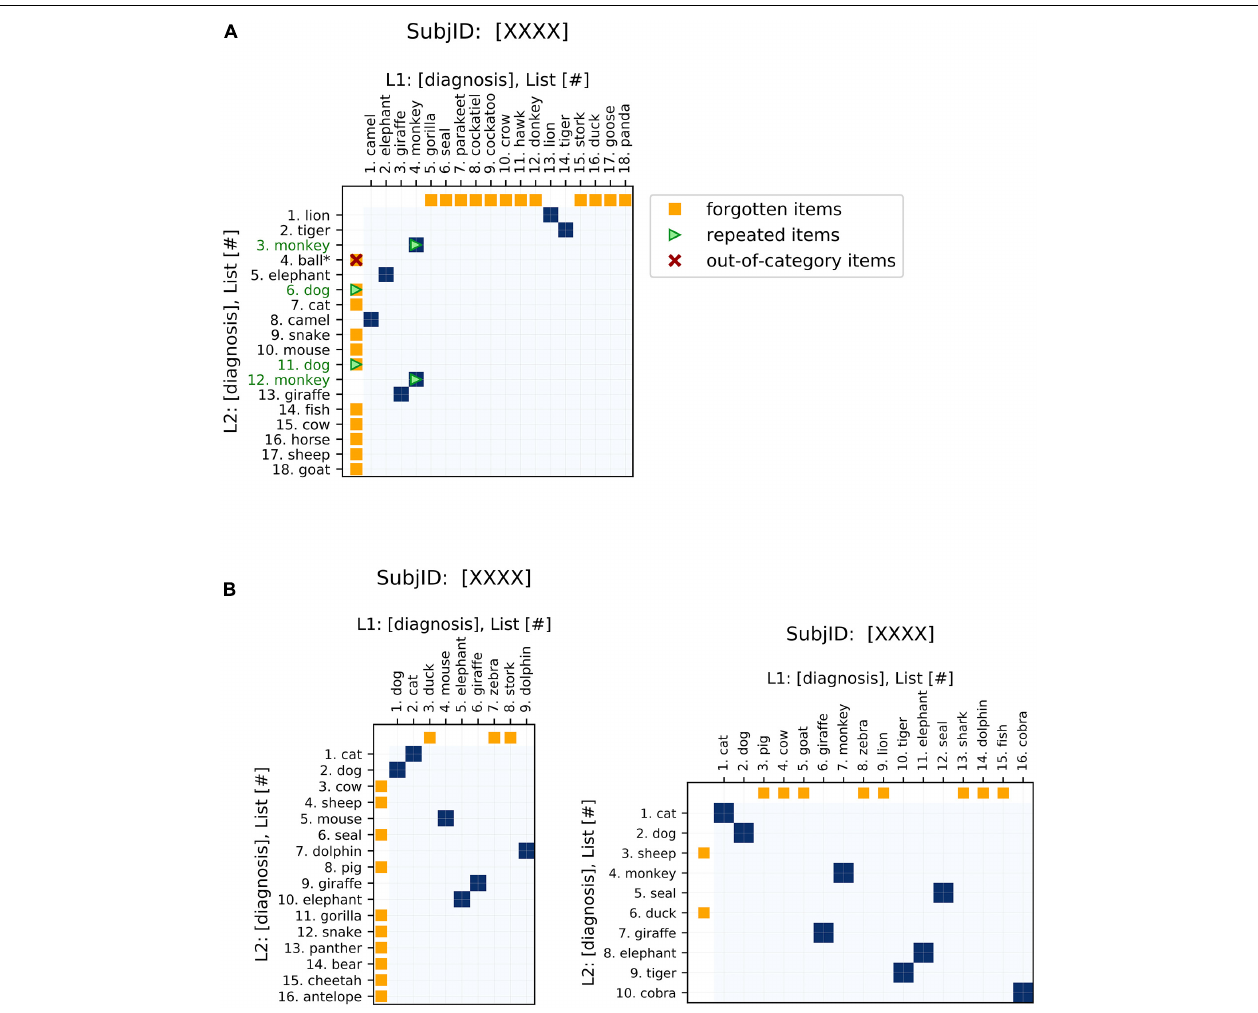
FIGURE 2 | Basic features of semantic fluency visualizations. (A) The first sequence (chronologically) is plotted on the x-axis and the second on the y-axis. Areas of similarity are shaded in blue. Items present in one sequence but forgotten in the other are indicated by orange points on the corresponding axis, i.e., orange points on the x-axis indicate items present in the first (x-axis) list but missing from the second (y-axis) list. Repeated items are indicated by green arrows and green item labels. For semantic fluency data specifically, invalid (out-of-category) items, also referred to as intrusions, are indicated by a red “x” and asterisk. Repetitions and out-of-category items can occur as words present in both lists (blue points) or just in one list (orange), so these markers are overlaid on the appropriate color point. (B) Changes in sequence length are easily visualized via the aspect ratios of the plots. Square plots correspond to no change, landscape-oriented rectangles (right) correspond to the second sequence being shorter in length, and portrait-oriented rectangles (left) correspond to the second sequence being